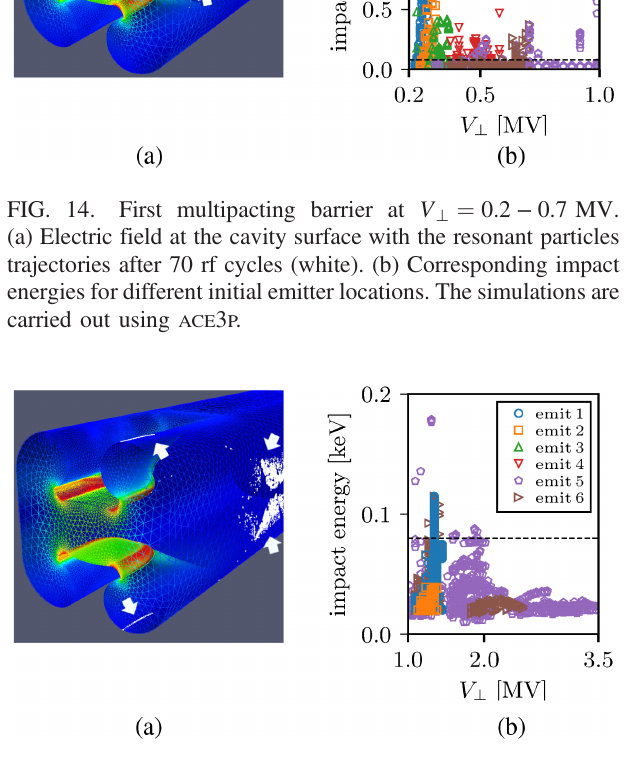
FIG. 15. Second and third barrier at V ⊥ ¼ 1 − 2 MV. (a) Elec- tric field at the cavity surface with the resonant particles trajectories after 70 rf cycles (white). (b) Corresponding impact energies for different initial emitter locations. The simulations are carried out using ACE 3 P .